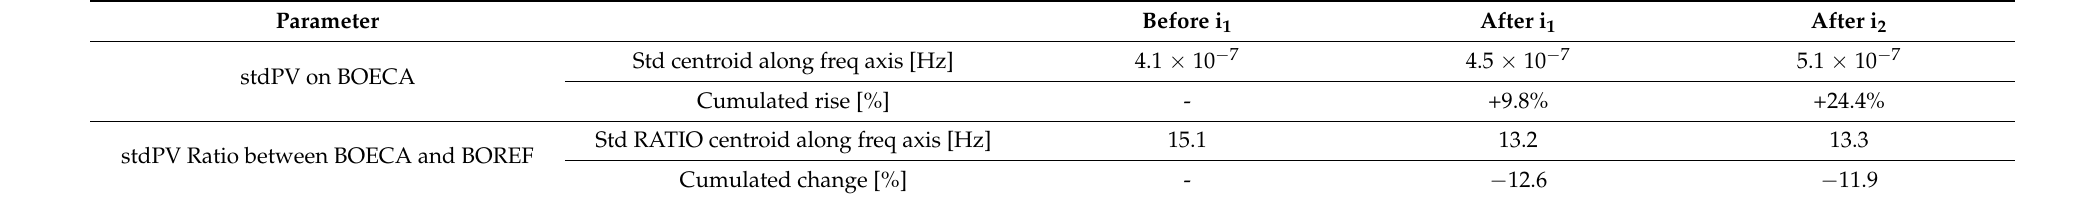
Table A1. PV changes between bolting stages.